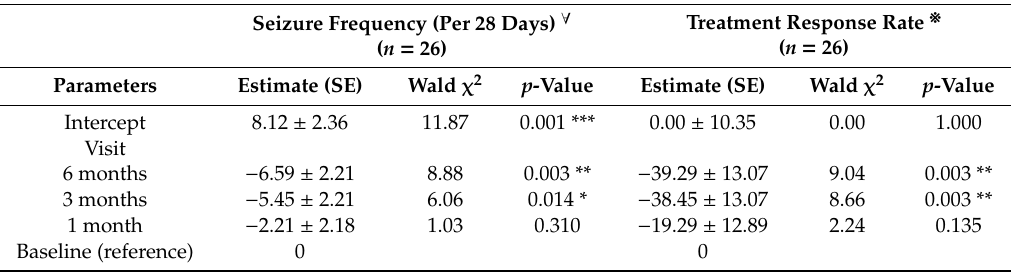
Table 4. Generalized estimating equations analysis of seizure frequency and treatment response rate after 6 months of multivitamin supplementation in the patients with intractable focal epilepsy (crude).